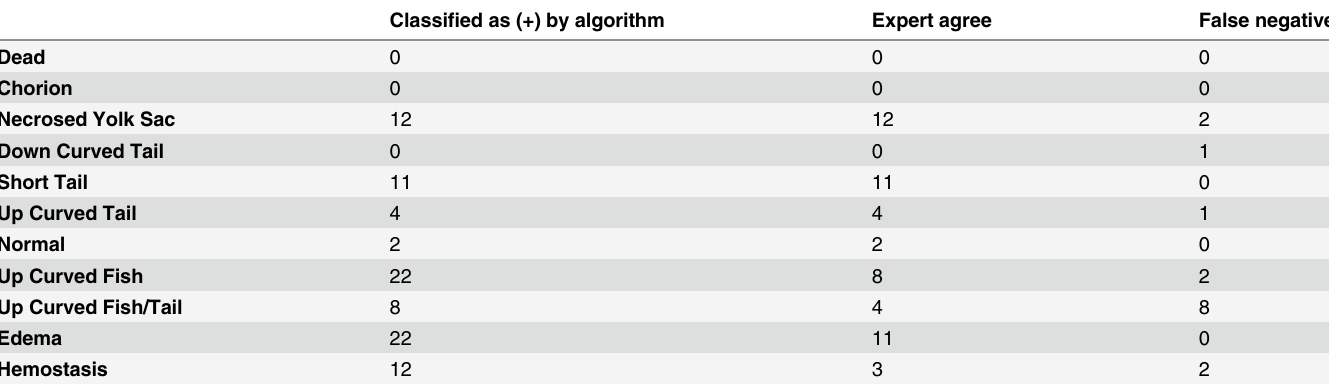
Table 4. Automatic classi fi cation of “ dif fi cult ” images and “ a posteriori ” expert agreement.